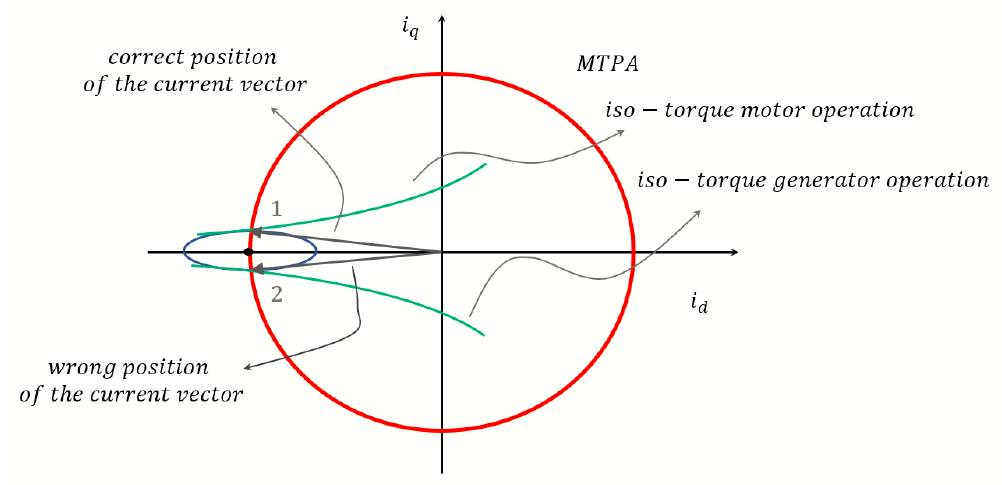
Figure 3. Current vector position at high-speed operations where: 1. motor operating region, 2. generator operating